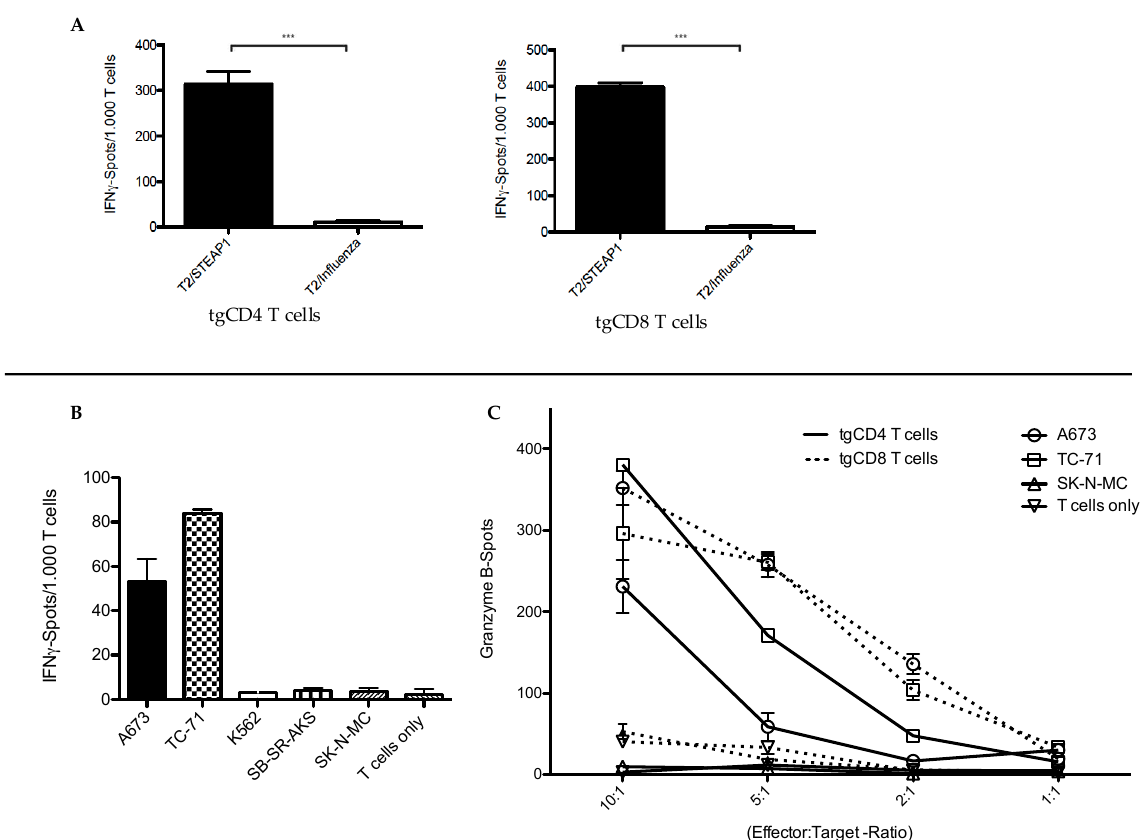
Figure 3. Peptide specificity and e ff ector cytokine release of STEAP1 130 / HLA-A*02:01-specific TCR transgenic CD4 + (tgCD4) and CD8 + (tgCD8) T cells in vitro. ( A ) IFN γ ELISpot analysis, comparing tgCD4 and tgCD8 T cells (1.000 T cells per 20.000 peptide-loaded T2 cells (STEAP1 130 - and influenza control-peptides). ( B ) IFN γ -ELISpot analysis of tgCD4 T cells when co-cultured with HLA-A*02:01-positive (A673, TC-71) and HLA-A*02:01-negative target cells (1.000 T cells per 20.000 target cells). ( C ) Granzyme B-ELISpot analysis of tgCD4 and tgCD8 T cells at di ff erent e ff ector-to-target ratios (20.000 target cells). Error bars represent the standard deviation of triplicate experiments. Asterisks indicate significance levels. * p < 0.05; ** p < 0.005; *** p < 0.0005; ns = not